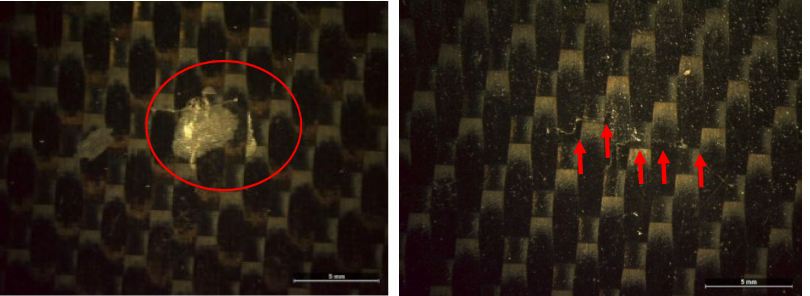
Figure 5. Optical images of the damages observed on the front faces of panels 13 ( left-hand side ) and 15 ( right-hand side ).